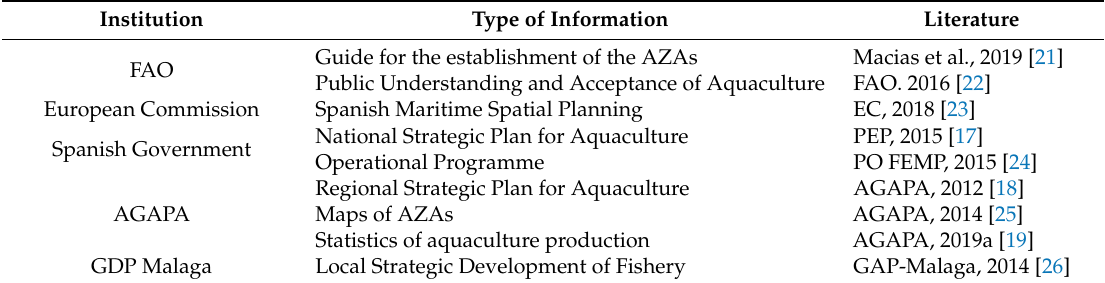
Table 1. List of international, national, regional, and local documents analyzed (Acronyms: AZAs: Allocated zones for Aquaculture).